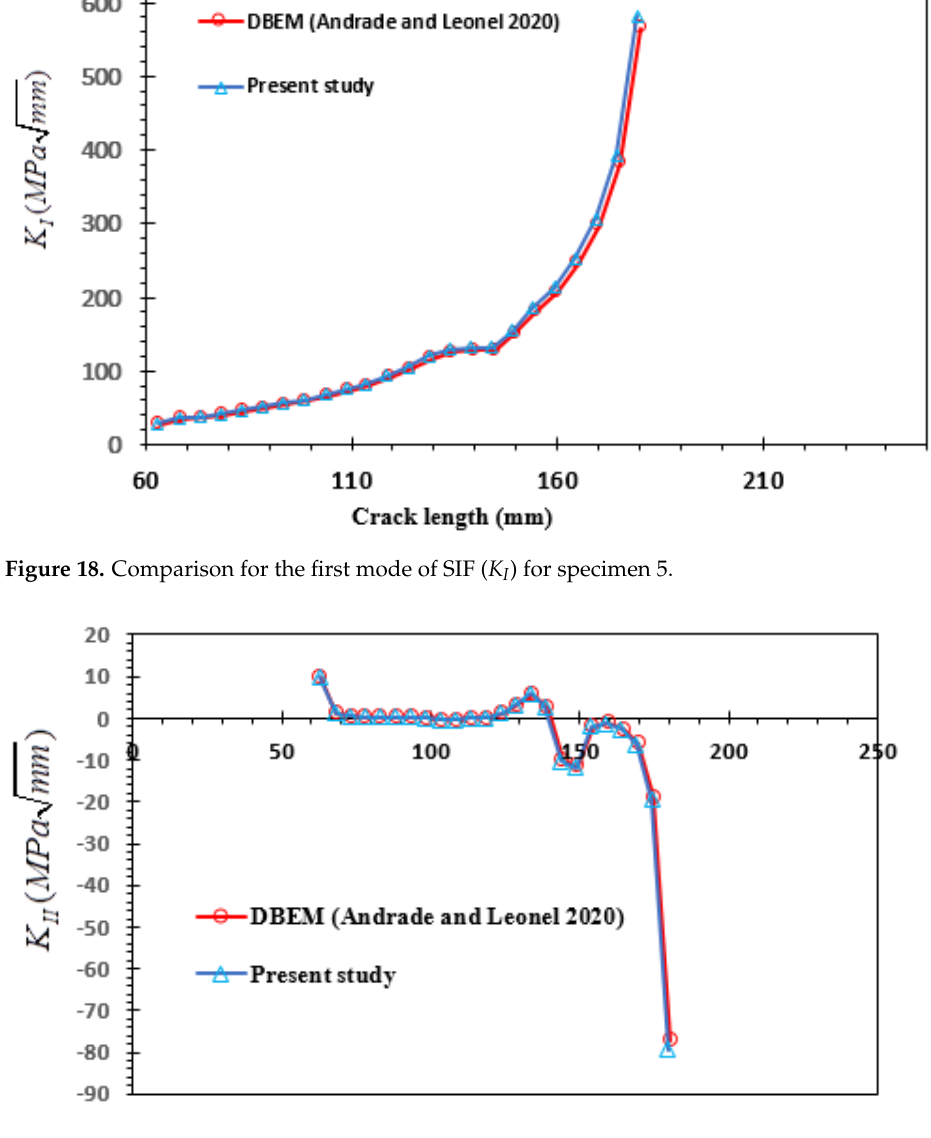
Figure 19. Comparison for the second mode of stress intensity factor ( K II ) for specimen 5.